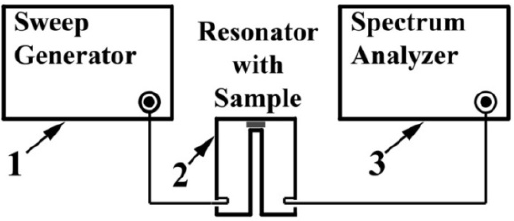
Figure 18. The scheme of an experimental setup for measuring ε and tanh( δ ) in a coaxial resonator with an end gap.